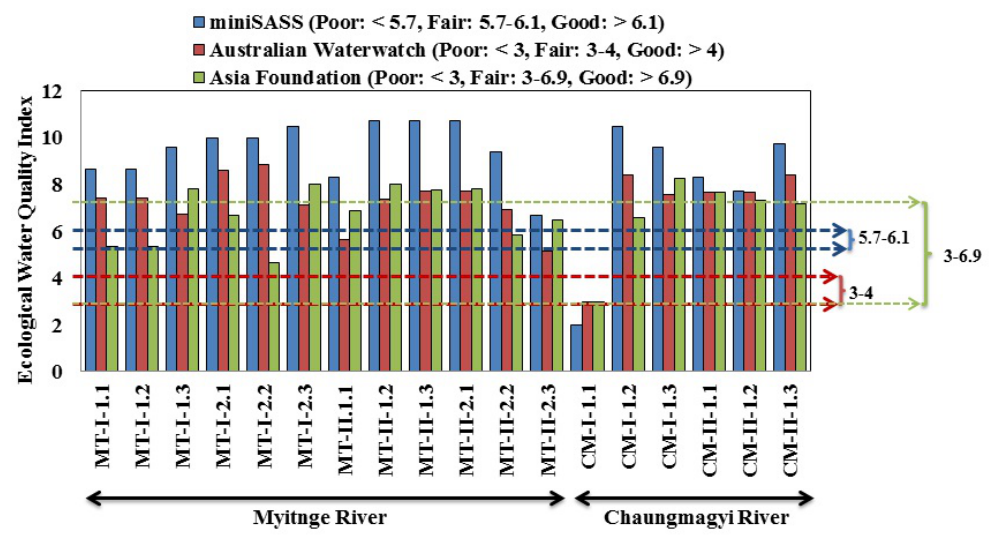
Figure 2. Estimated ecological water quality indices by three methods per sample of each site on the Myitnge and Chaungmagyi Rivers for two